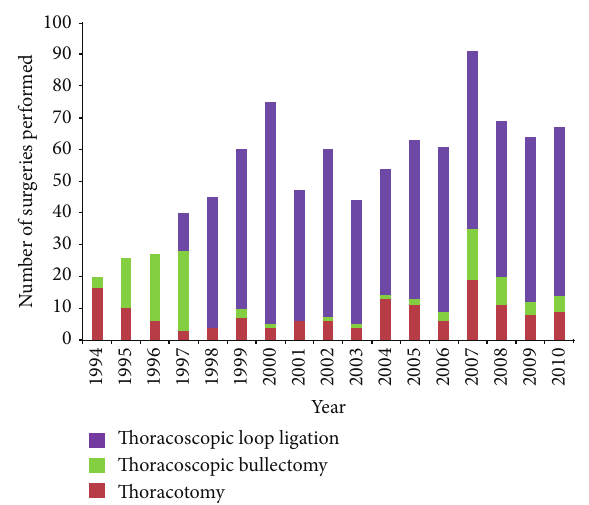
Figure 2: Distribution of thoracotomy, thoracoscopic bullectomy, and thoracoscopic loop ligation performed at the National Hos- pital Organization Chiba-East Hospital between January 1994 and December